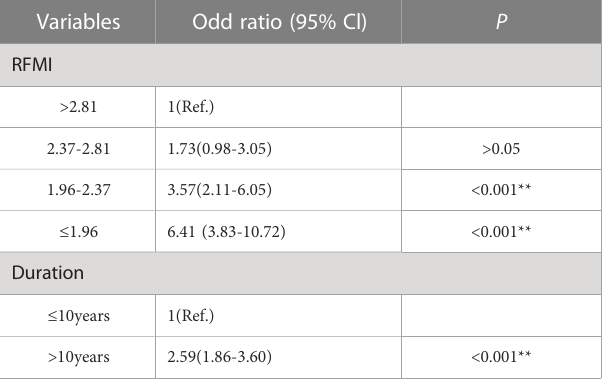
TABLE 5 Risk factors of DPN in multivariate logistic regression. Variables